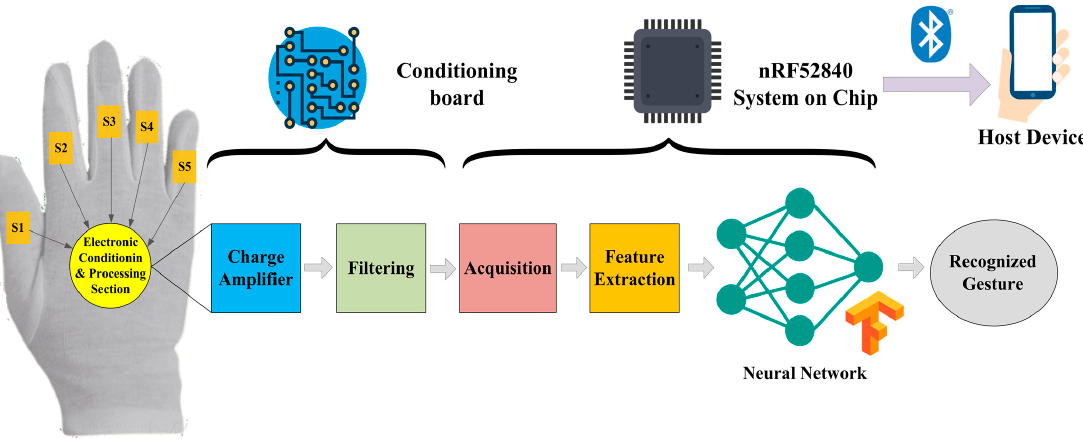
Figure 20. Block diagram reporting the overall architecture of the proposed AlN-based piezoelectric glove.